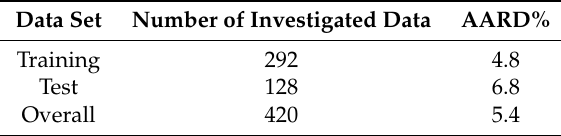
Table 3. The number of investigated data in the different datasets and the corresponding AARD% of the proposed model.